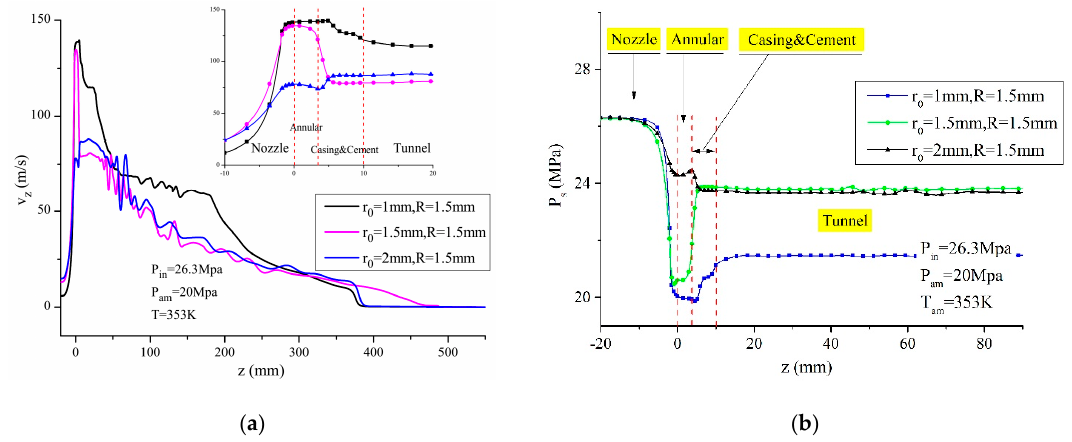
Figure 15. The effect of aperture ratio on the distribution of axial velocity and static pressure. ( a ) Axial velocity of jetting; ( b ) Total pressure on the perforation.